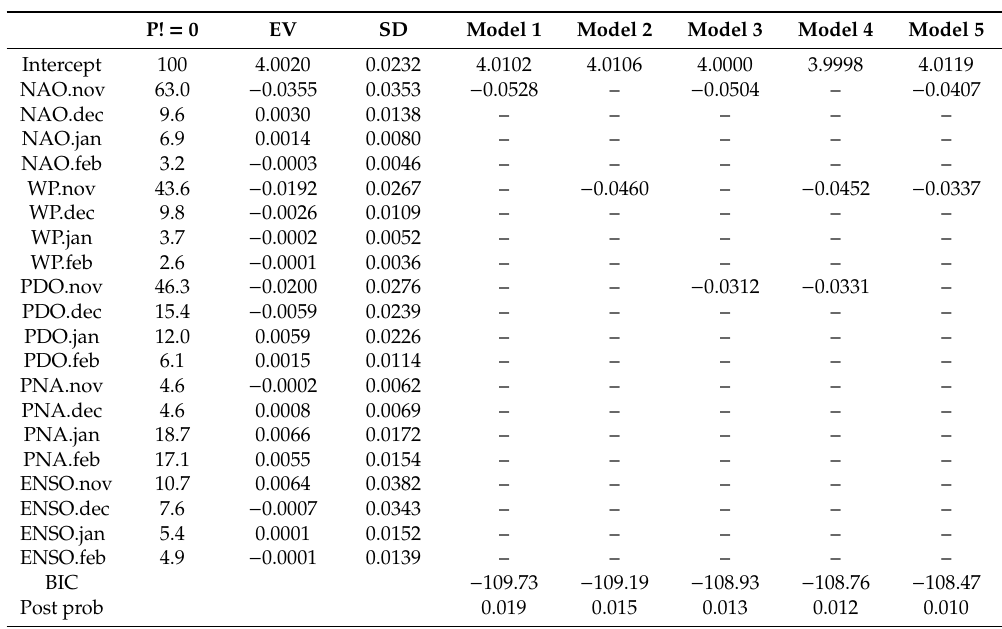
Table 1. Posterior statistics of the output from a BMA procedure. The P! = 0 is the posterior probability of the model parameter. The EV and SD are the expected value and standard deviation of the posterior parameters, respectively. The values under the model numbers are the regression coe ffi cients with positive values indicating a positive relationship between the covariate and the probability of a extratropical cyclone.